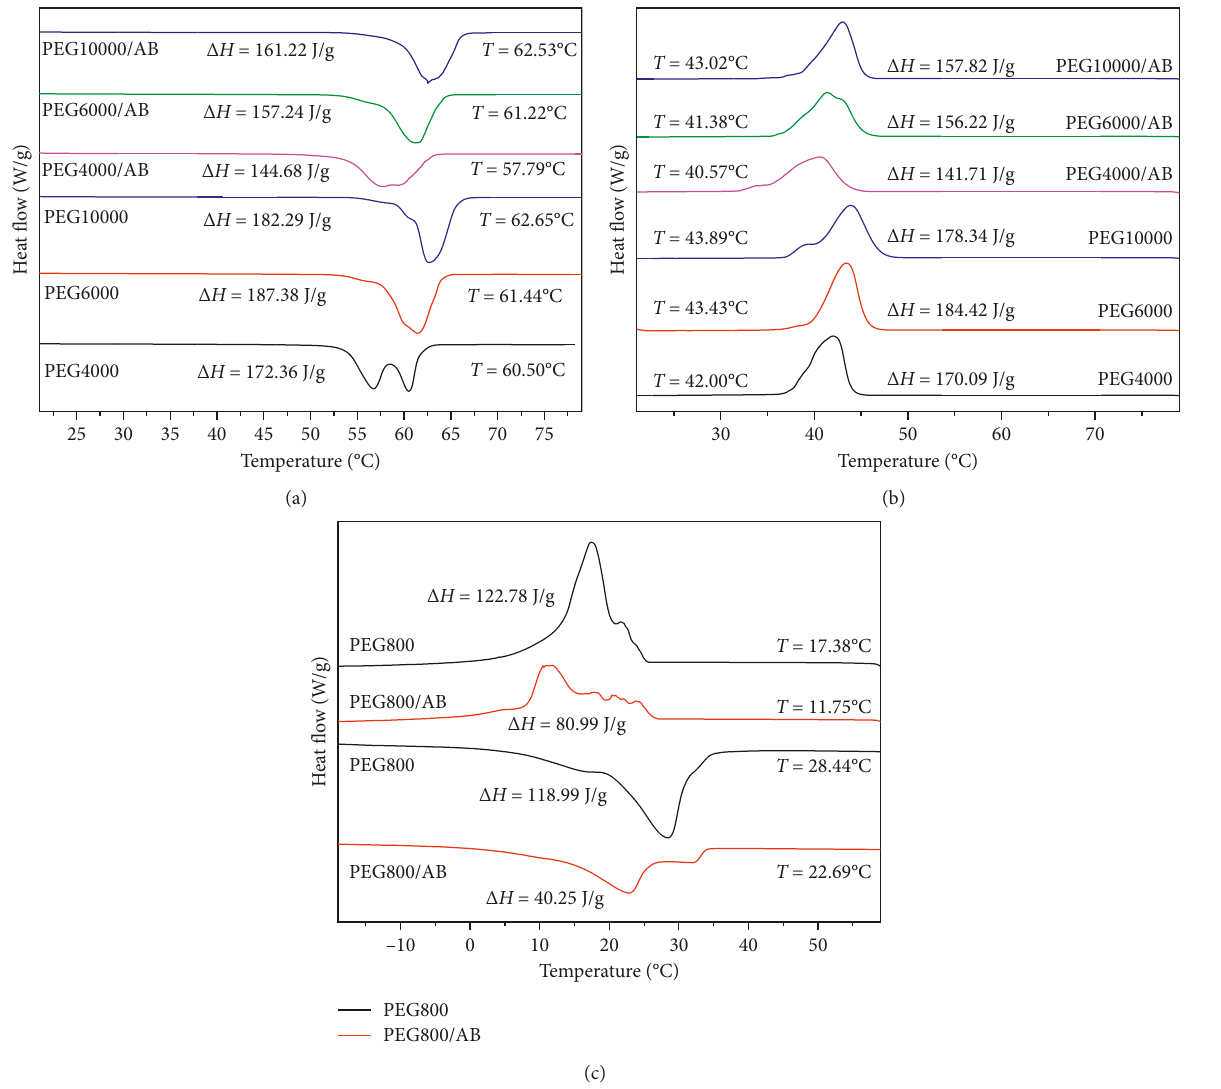
Figure 7: Cyclic DSC heating (a) and cooling (b) curves of pristine PEG4000, PEG6000, PEG10000, and their shape-stabilized PEG/AB composites. (c) DSC curves of PEG800 and PEG800/AB